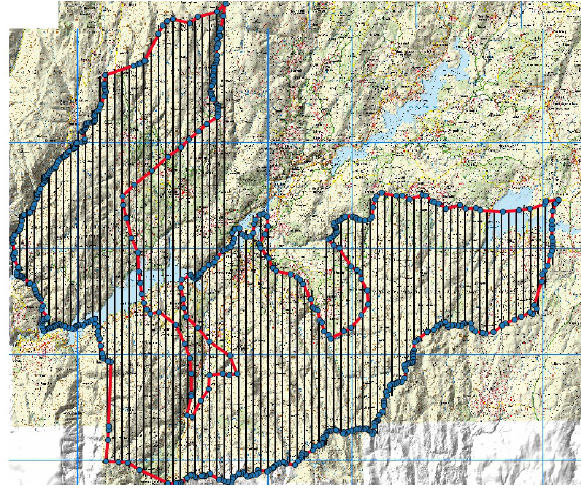
Figure 10. Serra do Xures natural park limits. Original shape points in blue and densified border in red. Mission route is exhibited with a black line.